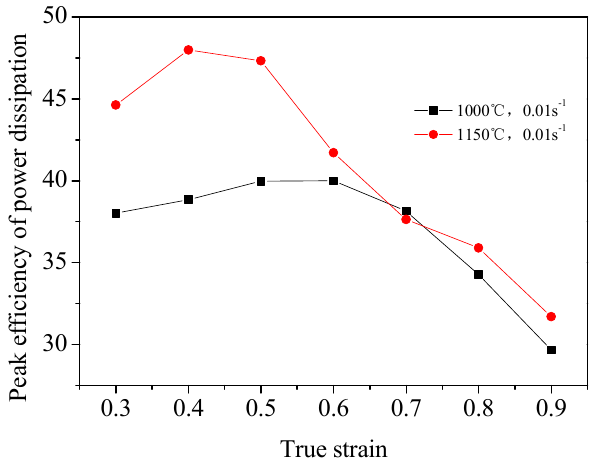
Figure 10. Variation in the efficiency of power dissipation with true strain at the deformation temperature of 1100 °C and 1150 °C and the strain rate of 0.1 s − 1 .